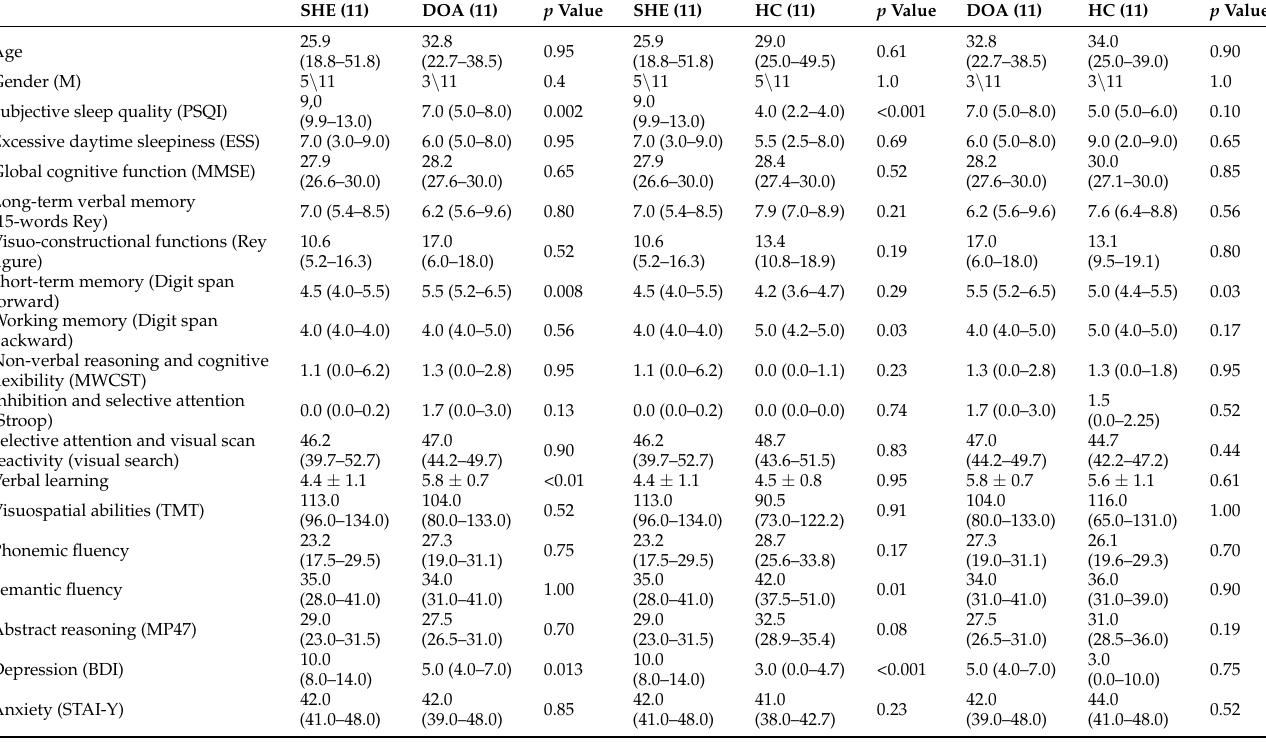
Table 1. Demographic, clinical, neuropsychological, and behavioral data of the SHE group, DOA group, and healthy control group.